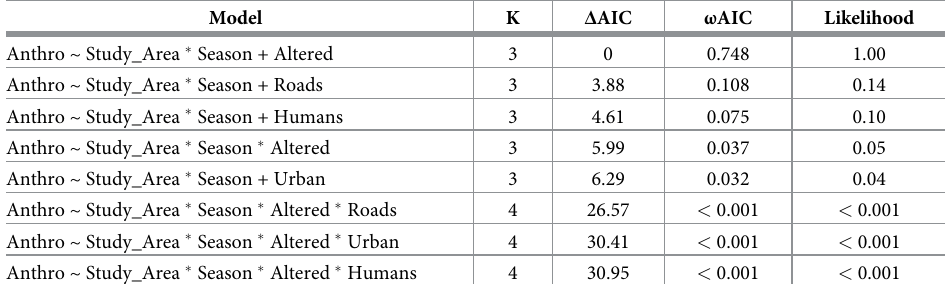
Table 2. AIC model selection results for FO of anthropogenic items in coyote scat. Model K Δ AIC ω AIC Likelihood Anthro ~ Study_Area � Season + Altered 3 0 0.748 1.00 Anthro ~ Study_Area � Season + Roads 3 3.88 0.108 0.14 Anthro ~ Study_Area � Season + Humans 3 4.61 0.075 0.10 Anthro ~ Study_Area � Season � Altered 3 5.99 0.037 0.05 Anthro ~ Study_Area � Season + Urban 3 6.29 0.032 0.04 Anthro ~ Study_Area � Season � Altered � Roads 4 26.57 < 0.001 < 0.001 Anthro ~ Study_Area � Season � Altered � Urban 4 30.41 < 0.001 < 0.001 Anthro ~ Study_Area � Season � Altered � Humans 4 30.95 < 0.001 < 0.001 AIC results for model selection used to identify the best model(s) to predict the effect of land use and seasonality on anthropogenic food consumption in coyote scats. “Anthro” = frequency of occurrence (FO; see above for a more detailed definition) of anthropogenic items in coyote scats; “Study_Area” = urban or suburban study area; “Season” = wet (Nov-Apr) or dry (May-Oct) season; “Altered” = percent of buffer zone that is altered open space (e.g., golf courses, cemeteries, city parks); “Roads” = km/km 2 of roads in the buffer zone; “Humans” = human density (10,000 people/km 2 ) in the buffer zone; “Urban” = percent of the buffer zone that is urban land (commercial/industrial and residential land uses). three months. A total of 61 vibrissae were analyzed: 29 vibrissae from urban coyotes, 21 vibris- sae from suburban coyotes, and 7 vibrissae from rural coyotes. The average number of sub- samples per vibrissa (i.e., replicates per individual) was 16 ± 7 SD (S2 Table). Isotope signatures of particular prey species (e.g., ground squirrels or rabbits) were not sig- nificantly different between study areas ( F = 0.6, p = 0.8). Therefore, we used samples col- 5,65 lected from all areas to calculate mean isotope values and associated variance (SD) of potential foods. We found significant differences in δ 13 C and δ 15 N values among potential food sources = 58.5, p < 0.001; δ 15 N: F = 8.2, p < 0.001). For δ 13 C, domestic cats (–16.7 ± ( δ 13 C: F 5,63 5,63 1.7‰, n = 12) and humans (–18.9 ± 0.9‰, n = 14) had higher mean ( ± SD) values than all other food sources. Ground squirrels (–22.7 ± 0.9‰, n = 12), rabbits (–23.0 ± 2.0‰, n = 12), and pocket gophers (–23.6 ± 2.2‰, n = 11) had similar δ 13 C values. Jerusalem crickets (–25.9 ± 1.1‰, n = 10) had values lower than mammals, but higher than plant material. Figs (–28.3 ± 2.2‰, n = 7) had the lowest δ 13 C value. For δ 15 N, humans (8.5 ± 0.7‰) had higher mean val- ues than all other food sources. Ground squirrels (6.6 ± 1.4‰) and domestic cats (6.6 ± 0.74‰) had similar δ 15 N values that were higher than other food sources. Figs (5.5 ± 3.4‰), pocket gophers (5.0 ± 1.3‰), and rabbits (4.9 ± 2.1‰) had similar δ 15 N values. Jerusalem crickets had the lowest δ 15 N value (3.6 ± 1.6‰). Individual coyotes occupied a large portion of the δ 13 C versus δ 15 N isotopic prey space defined by the isotope values of potential foods (Fig 3). We chose a threshold δ 13 C of –20.3‰ to differentiate natural from anthropogenic resources defined by the standard deviation of the natural prey source with the highest mean δ 13 C value (ground squirrels; [67]). This is theoreti- cally the maximum δ 13 C value a natural prey item can hold. This threshold is not meant to rep- resent a stark transition between food sources, but rather a transition from consuming more natural to more anthropogenic food sources. We estimated the isotope values of human food by subtracting 2.0 and 3.5‰ from measured human hair isotope values, which yielded mean ( ± SD) δ 13 C and δ 15 N values of − 20.9 ± 0.9‰ and 4.9 ± 0.7‰ for this potential food source [67]. Therefore, human foods have a unique isotope value relative to other sources of prey available to coyotes in Los Angeles. This value is also similar to other isotopic measurements of North American fast food [33,34] and similar to the “human food” reported for similar study in Chicago ( δ 13 C = -20 ± 0.9‰, δ 15 N = 5.5 ± 0.6‰; [67]).